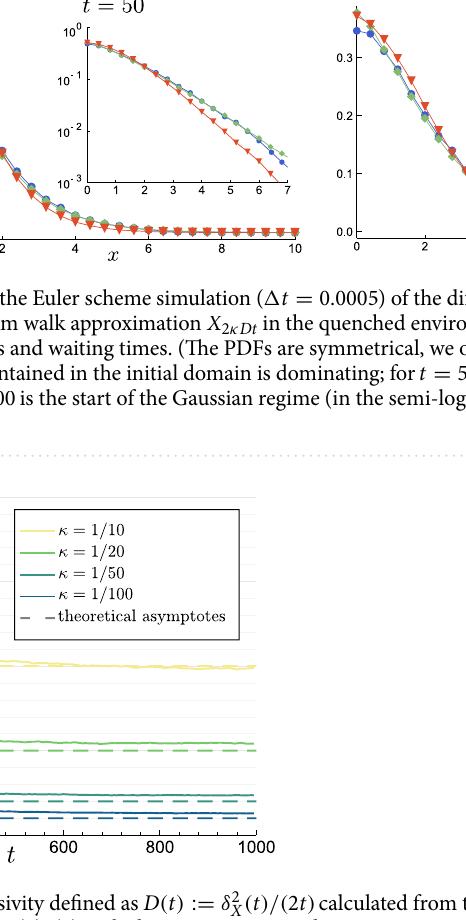
Figure 6. Time dependent diffusivity defined as D ( t ) of the transiently confined process (6), (7) with short time D the diffusivity D ( t ) starts at D ( 0 ) (12) derived for the annealed process. The range of D eff / D shown was suggested by the experiments of the hop diffusion 38